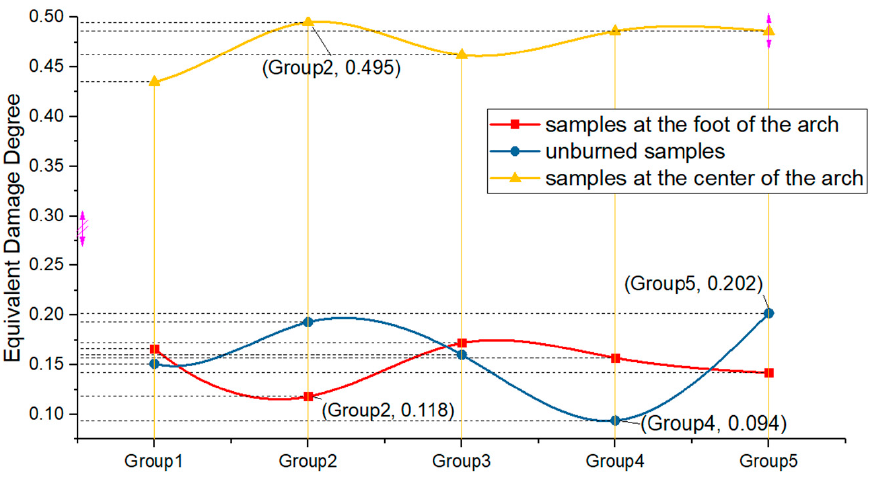
Figure 20. The 20 KG impact test for different parts of concrete lining structure.